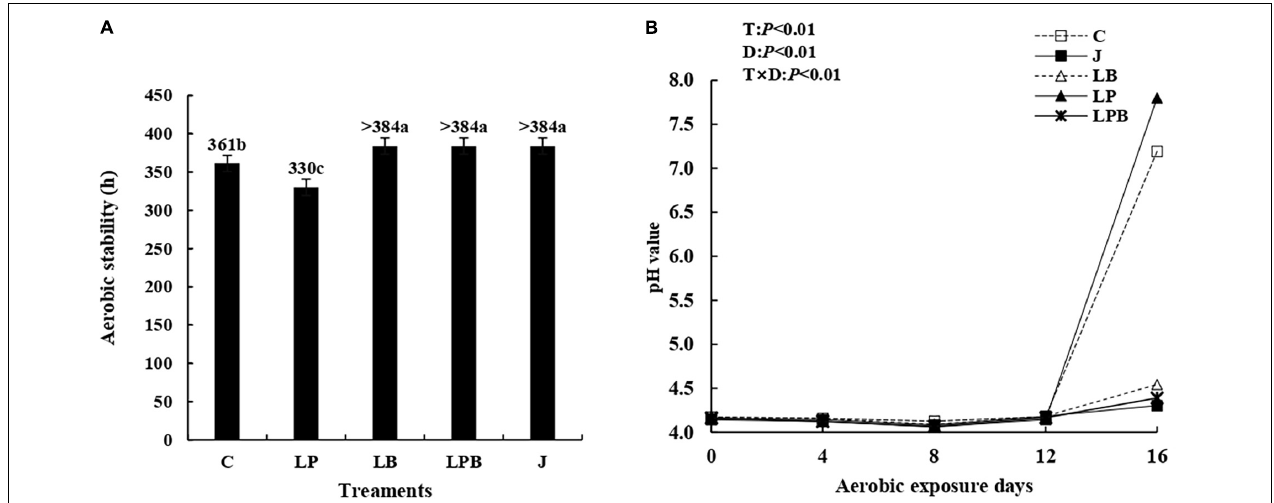
FIGURE 8 | Aerobic stability (A) and dynamics of pH (B) during aerobic exposure days. C, control; J, pre-fermented juice-treated silage; LP, L. plantarum -treated silage; LB, L. buchneri -treated silage; LPB, L. plantarum + L. buchneri- treated silage. D, ensilage days; T, treatments; T × D, the interaction between treatment and ensiling